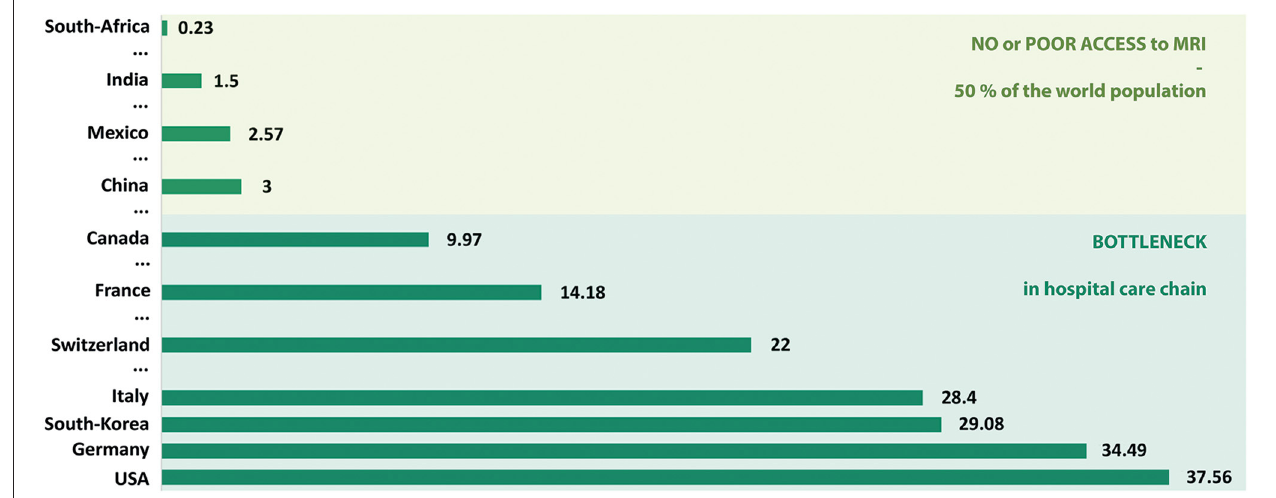
FIGURE 6 | Number of MRI units per million population. Only a sample of countries are presented here in order to simply illustrate the current MRI market worldwide. Data extracted mainly from Statistica.com, 2017 reports.